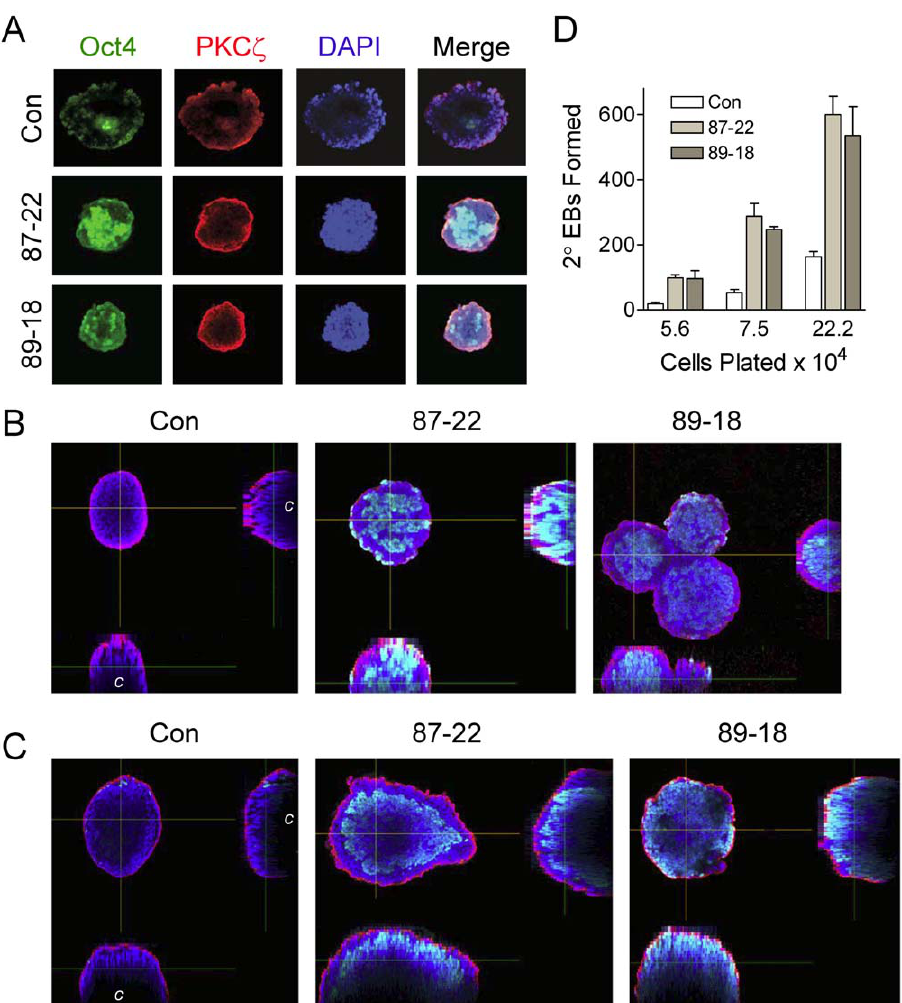
Figure 8. EBs formed from Tim knockdown cells retain pluripotent cells. EBs were cultured from control and Tim knockdown ES cell lines Lenti:87-22 and Lenti:89-18 for 6 and 12 days. A , Fixed 6 day EBs were immunostained for the pluripotency marker Oct4 (green) and the zeta isoform of PKC (red) which marks tight junctions in the outer layer of visceral endoderm surrounding the EB. Nuclei were stained with DAPI (blue), and three- color images were obtained by confocal microscopy; a merged image is also shown. Optical sections from the middle of the EB show that cells present in the failed cavity of the Tim-knockdown EBs retain Oct4 staining, indicative of undifferentiated cells. B , Side profiles from merged images in part A ; the location of the cavity in the control EB is indicated with a ‘‘c’’. C , Side profiles from merged images obtained from 12 day EBs and stained as for 6 day EBs. D , Secondary EB assay. Six-day EBs from part A were trypsinized to single cells, replated in methylcellulose at the cell numbers indicated, and the number of secondary EBs present were counted ten days later. The mean number of secondary EBs formed from each culture 6 S.E.M. is shown in the bargraph (n=8). Both Tim knockdown cell lines produced significantly more secondary EBs than the parental control in each case (p ,